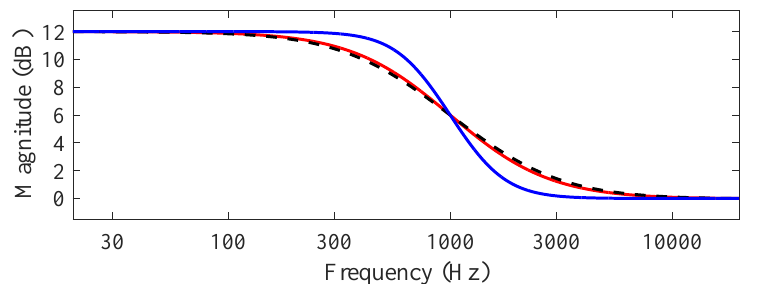
Figure 4. Magnitude responses of a single low shelf filter (red), cascaded two first order low shelf filters (black dotted line), and a second order shelf filter (blue) with the same gain (12dB) and crossover frequency